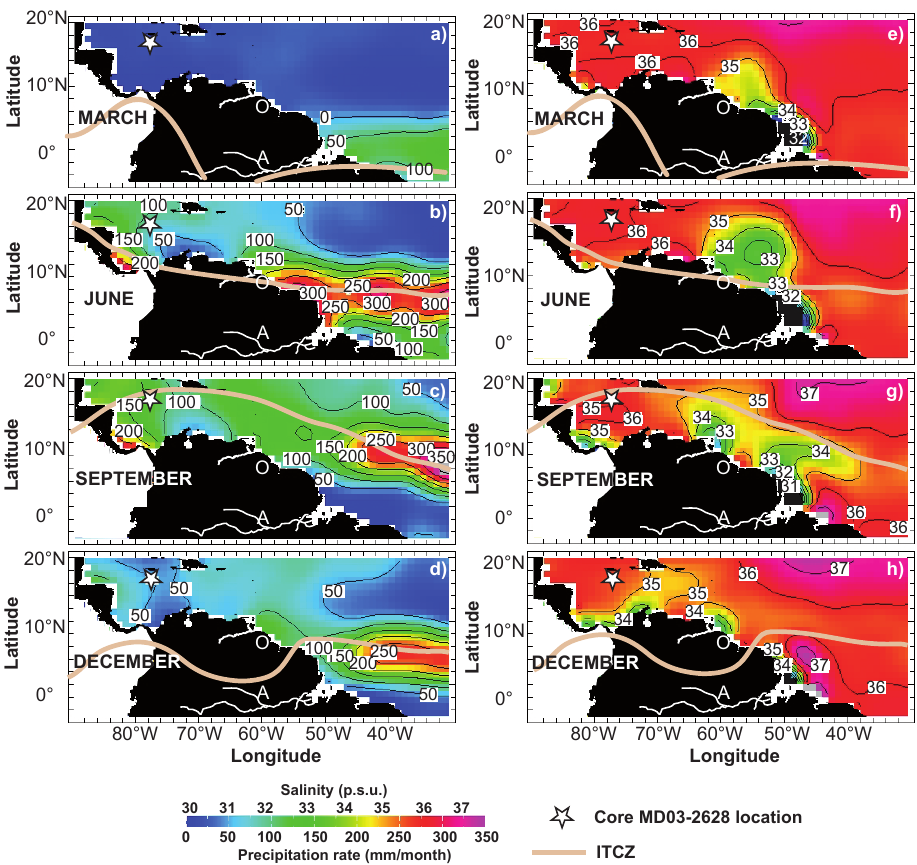
Fig. 3 Fig. 3. Maps of precipitation rates (a–d) and sea surface salinities (e–h) during March ( a and e ), June ( b and f ), September ( c and g ), and December ( d and h ). The core MD03-2628 location is shown by a star, and the ITCZ position is shown by the thick beige line (e.g., Haug et al., 2003). The Orinoco and Amazon Rivers are indicated by the O and A letters, respectively. Maps were constructed from http://ingrid.ldeo.columbia.edu/ using the DASILVA (da Silva et al., 1994) and LEVITUS (1994)